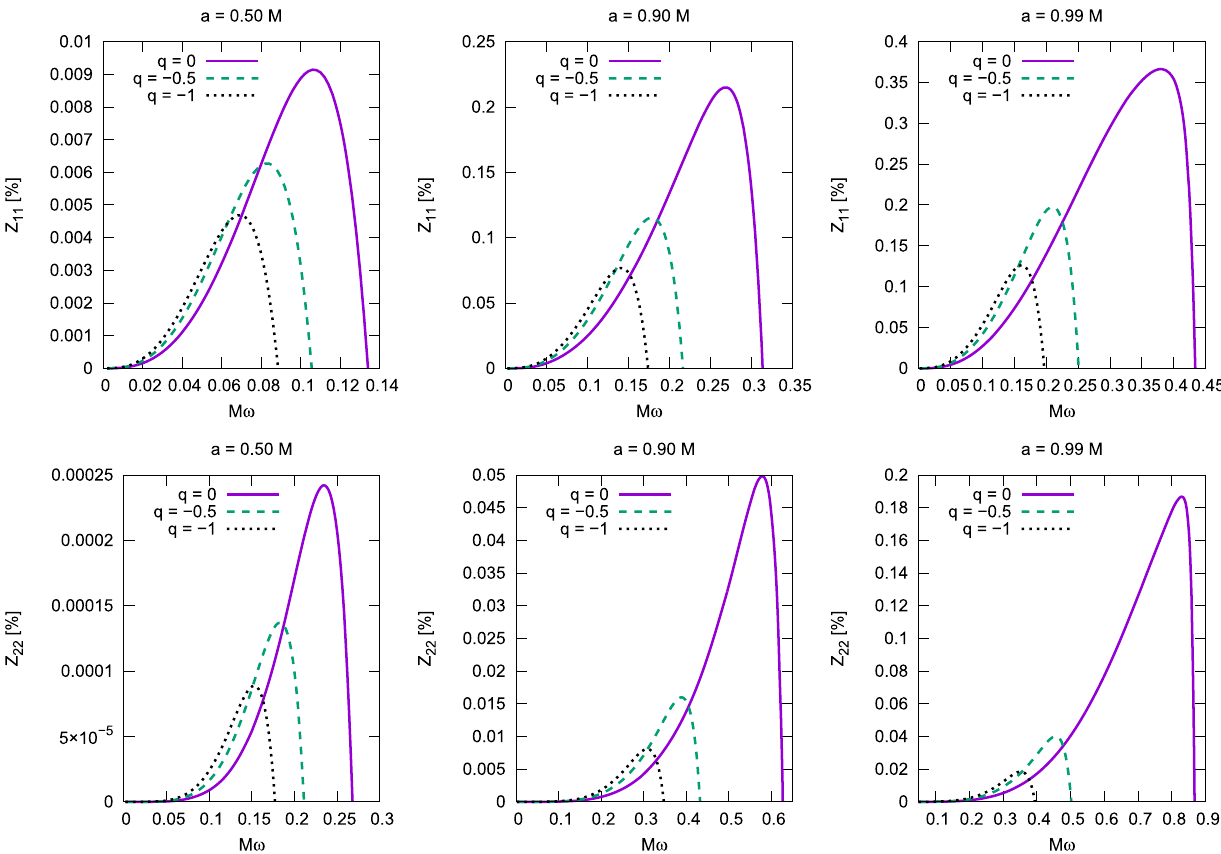
Fig. 4 Amplification factors for black holes with q = 0 , − 0 . 5 , − 1 for a = 0 . 5 M (left), a = 0 . 90 M (center) and a = 0 . 99 M (right). The considered modes are l = m = 1 (top) and l = m = 2 (bottom)